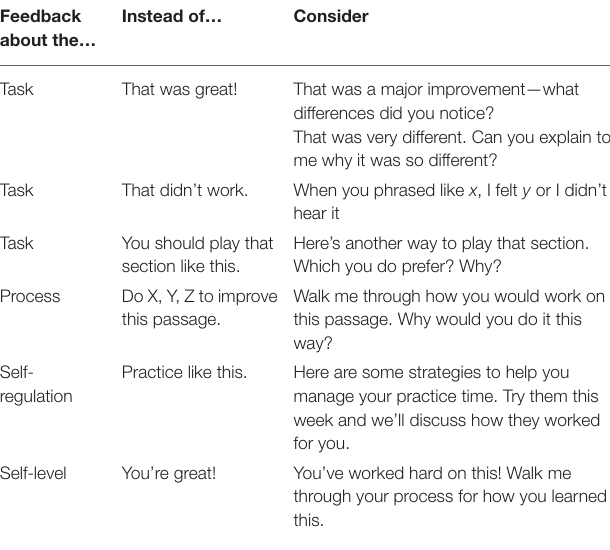
TABLE 2 | Examples of how to reshape feedback in music learning.